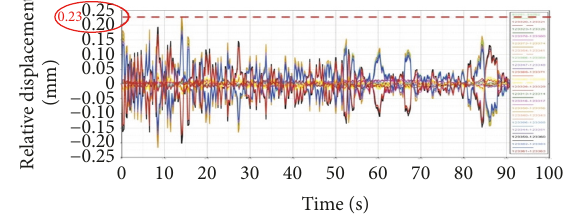
Figure 11: The relative displacement-time curve of the two ends of the spring under the excitation of 60